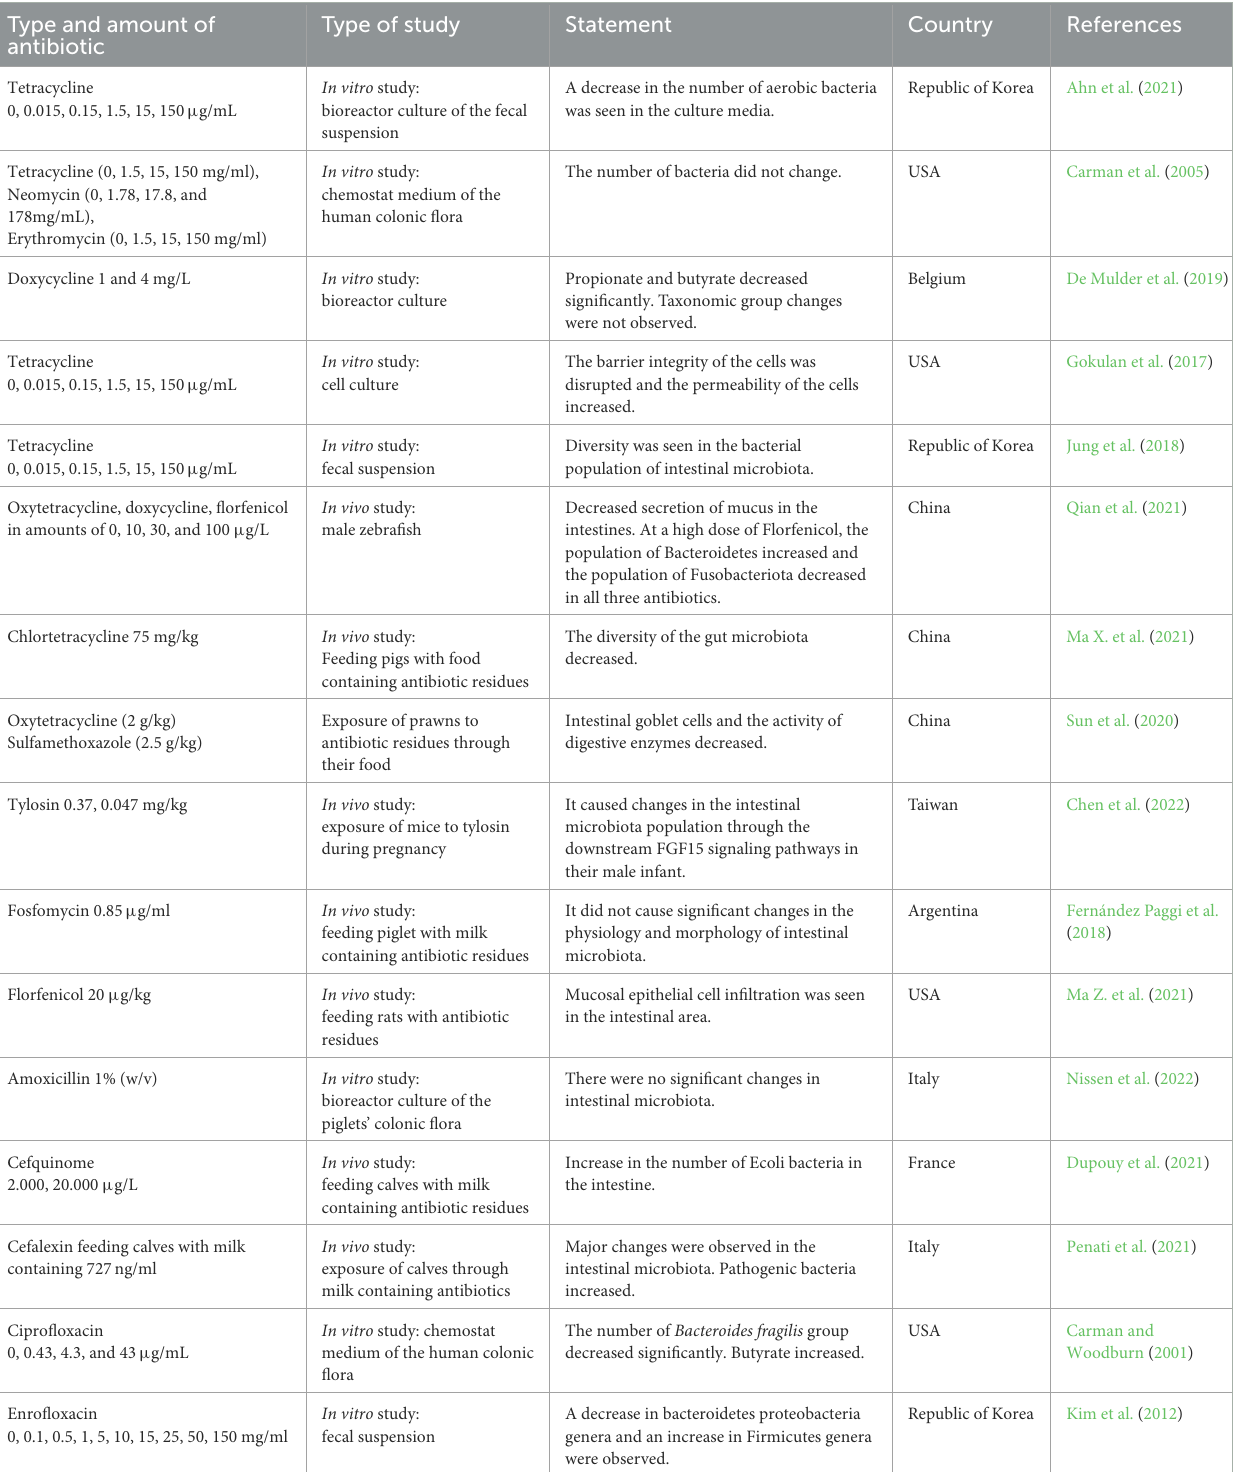
TABLE 1 Data extracted from selected manuscripts according to the inclusion